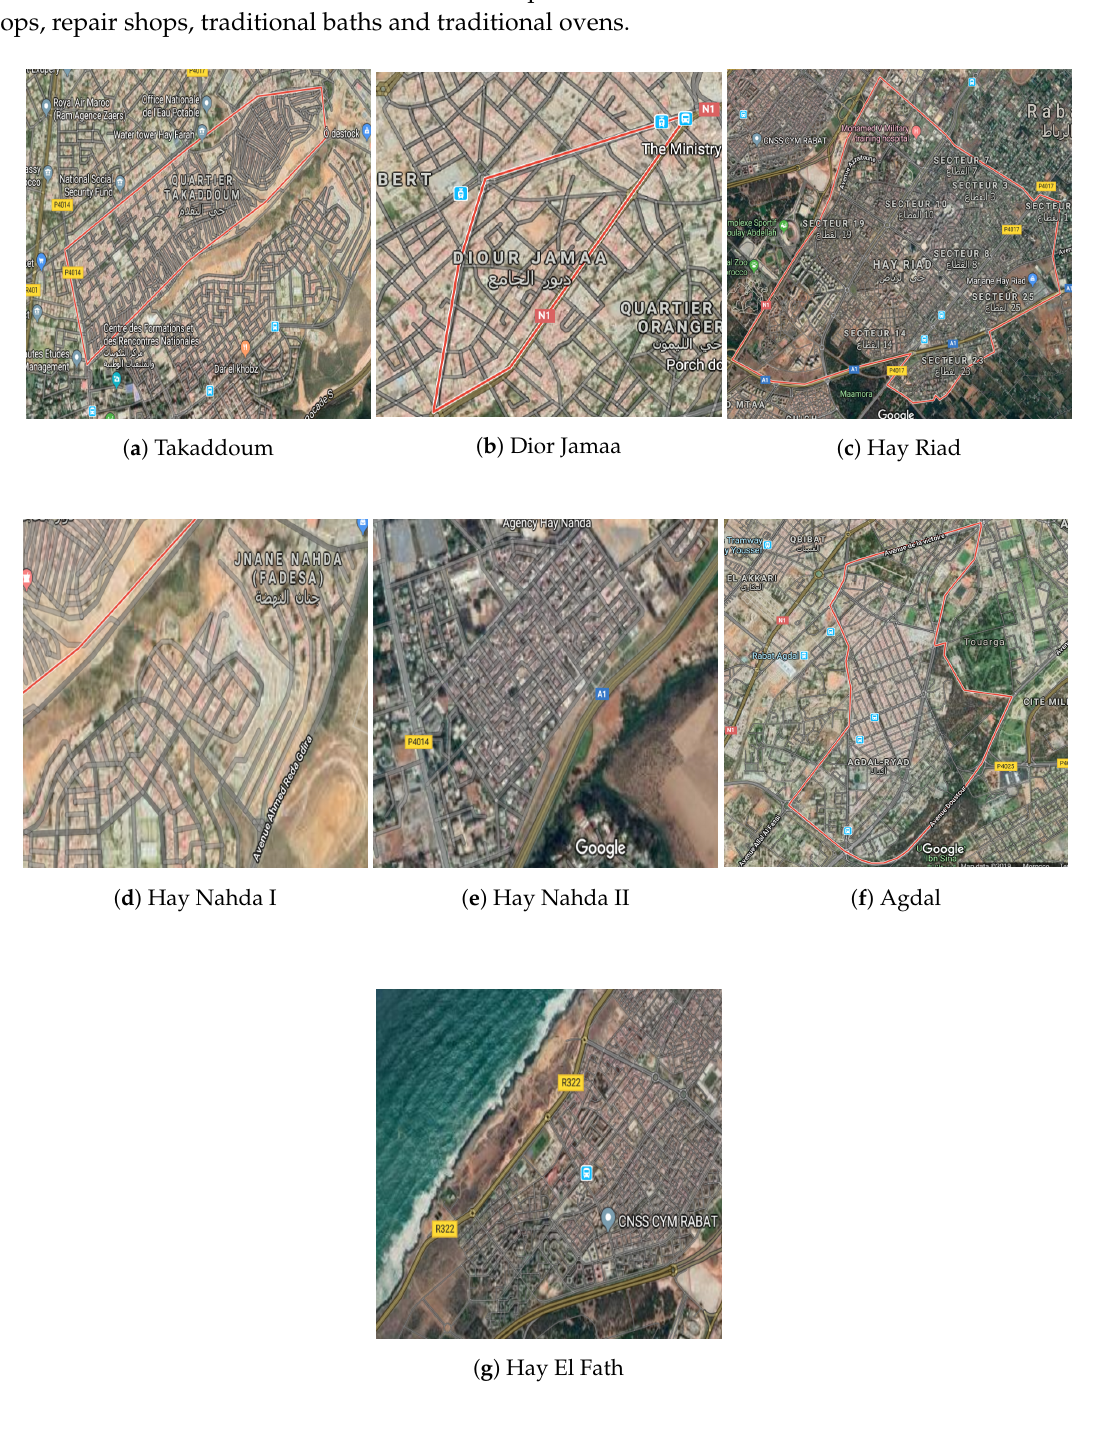
Figure 5. Location of the selected sites on Google